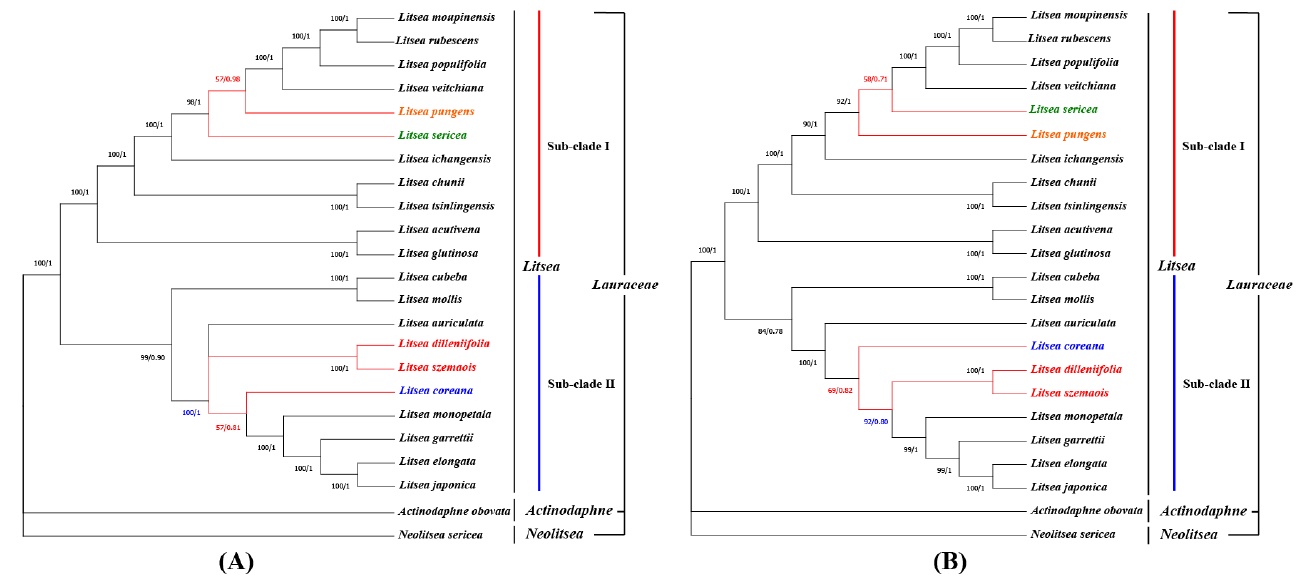
Figure 7. Phylogenetic analysis. ( A ) Phylogenetic tree based on the complete chloroplast genome. ( B ) Phylogenetic tree based on 64 sets of protein-coding genes. N. sericea and Actinodaphne obovata served as out groups. The colored branches show the difference between two trees. Numbers at branch nodes are bootstrap values and posterior probability.